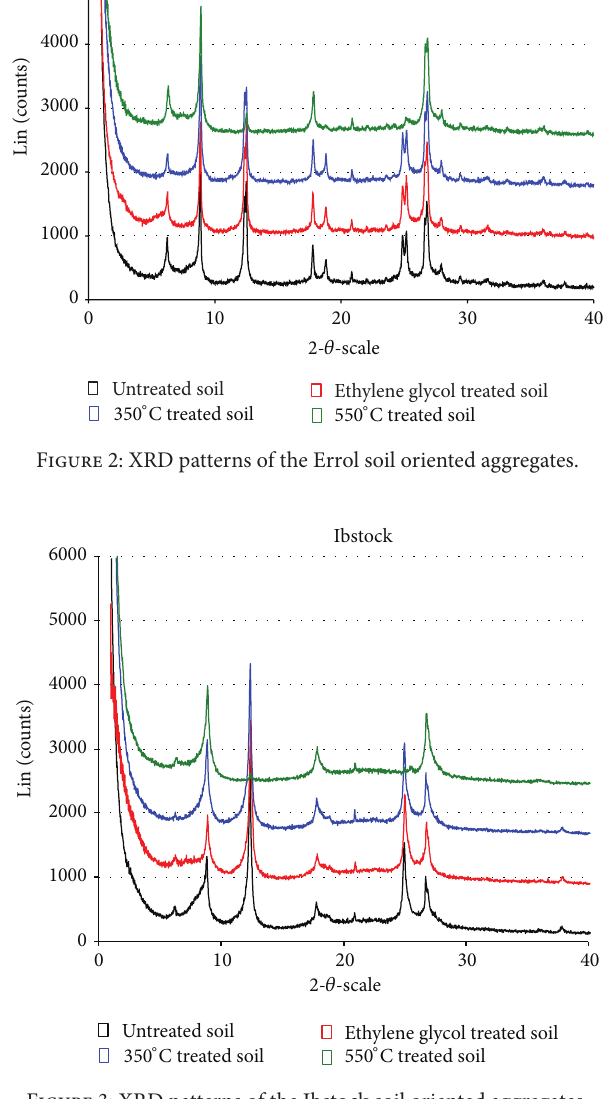
Figure 3: XRD patterns of the Ibstock soil oriented aggregates.